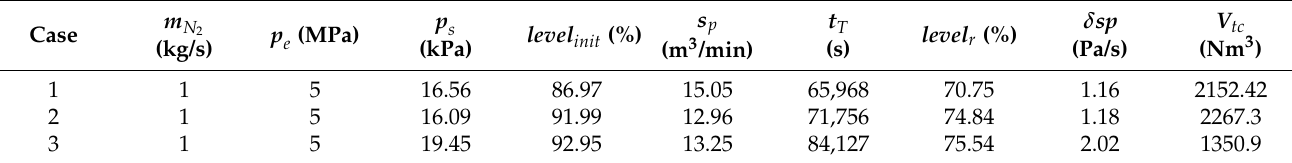
Table 6. Optimizing solutions for the liquid oxygen vacuumed subcooling